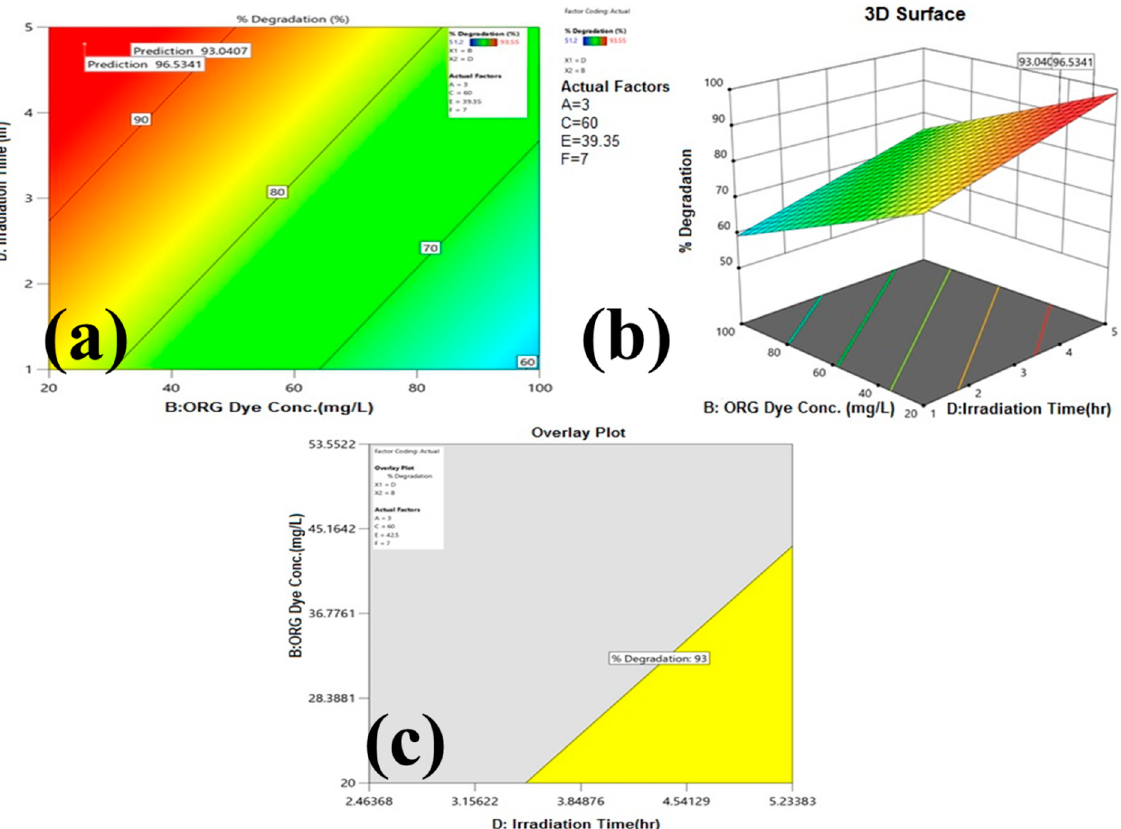
Figure 5. Contour plot and Three-dimensional response surface plots for ORG dye photocatalytic degradation: ( a ) Contour plot-ORG concentration vs. time of irradiation; ( b ) 3D Response surface plots-ORG concentration vs. time of irradiation; ( c ) overlay plot for design space (yellow region in the overlay plot is the operating range for significant factors). Several researchers used Orange G dye as a model pollutant for photocatalytic degradation comparative results, which are summarized in Table